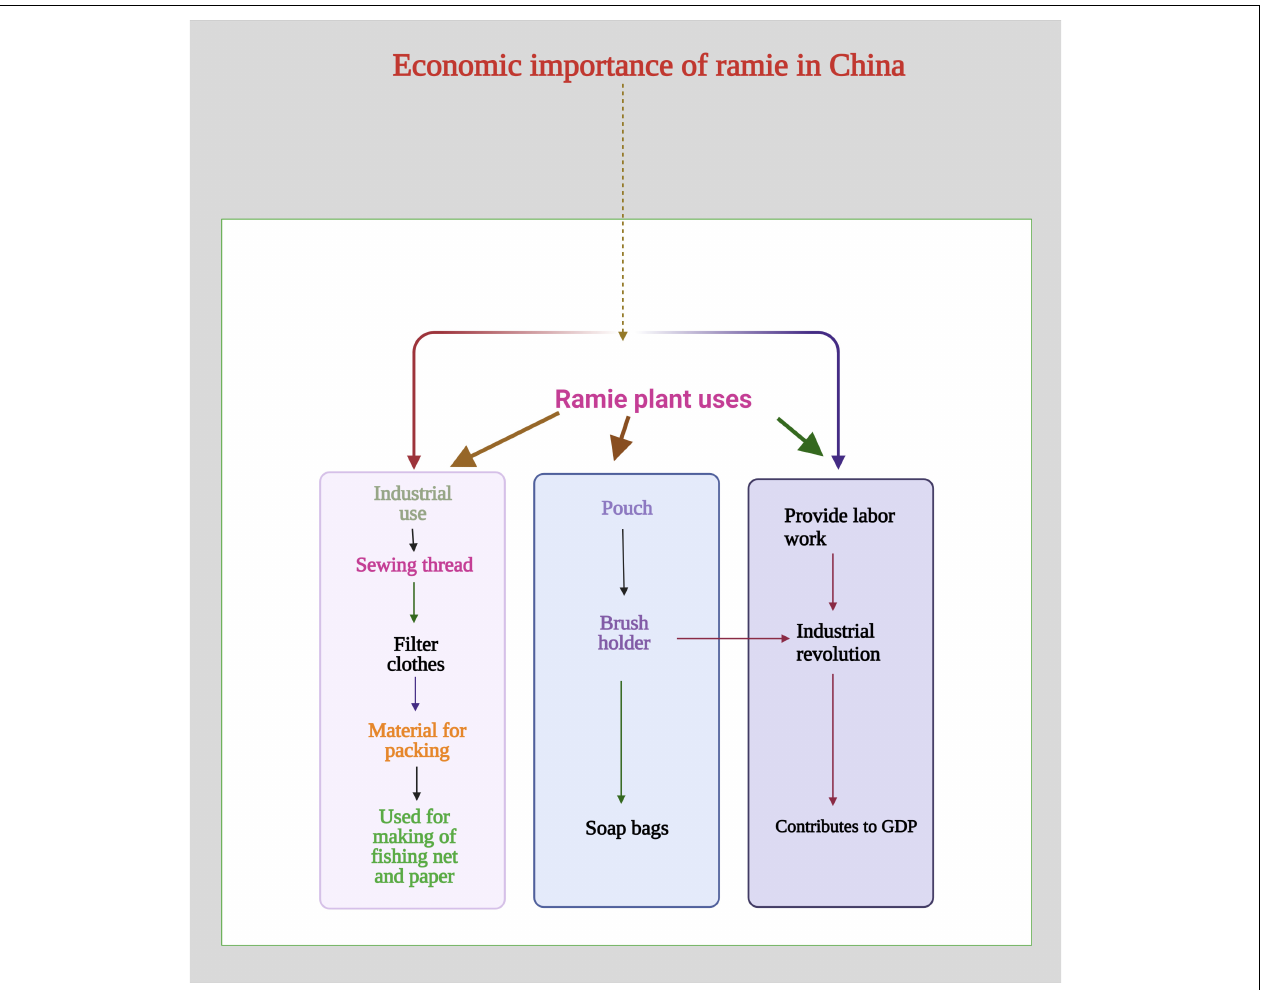
FIGURE 1 | Economic importance of ramie in China. Ramie is used for making sewing thread, filter clothes, packing material, fishing net, and paper. Ramie is also used for making pouch, brush holder, and soap bags. It provides labor work and has a significant contribution to gross domestic product